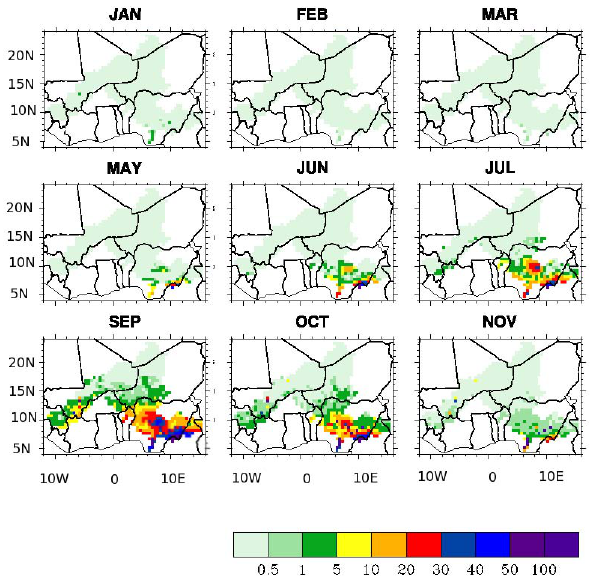
Fig. 14. Aquifer recharge distribution (mmyr − 1 )